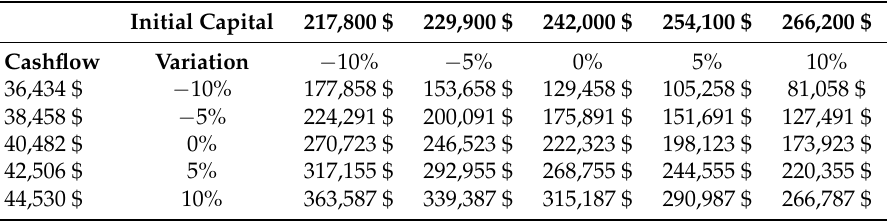
Table 5. WDCAS software sensitivity analysis.